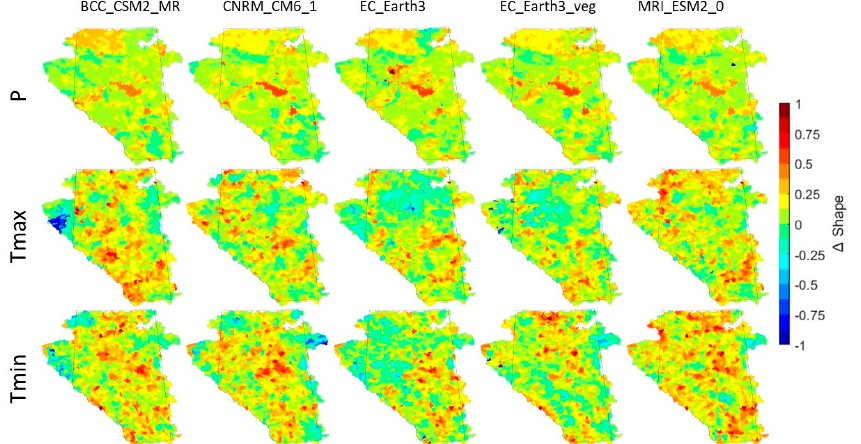
Figure 13. Spatial distribution of the delta tail index (shape parameter) between downscaled GCM simulations and observations of P, Tmax, and Tmin extremes for the 1983–2014 period for 2255 sub-basins. A positive shape indicates an overestimation by downscaled GCMs.